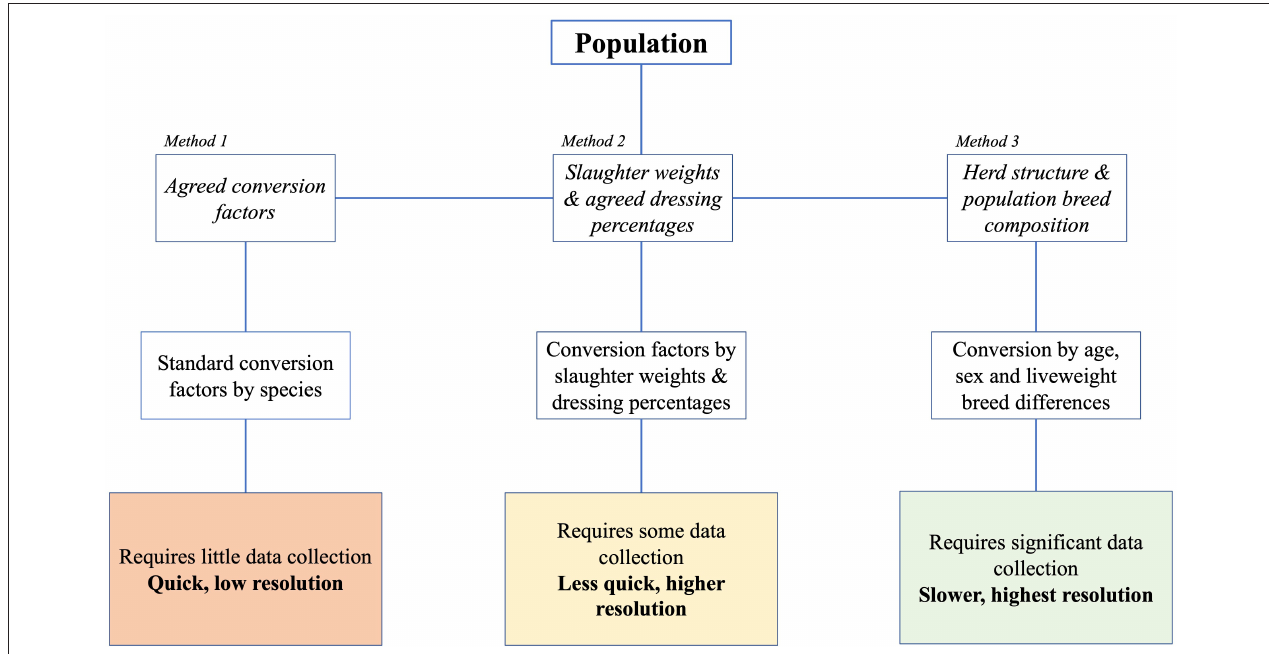
FIGURE 1 | Estimating tropical livestock units of a given [cattle] population requires an understanding of population biomass. Historically, herd biomass has been estimated by multiplying the population number by an average liveweight estimate of 175 kg (Method 1). We argue that while Method 1 may be expedient, it does not accurately represent population biomass. Therefore, we propose that an understanding of herd structure and breed composition, as well as an understanding of the age, sex, and breed liveweight differences is essential to a complete understanding of population biomass and conversion to an informed TLU calculation (Method 3). In the absence of data required to implement Method 3, an interim solution is use of slaughter weights and agreed dressing percentage to inform liveweight biomass estimation (Method